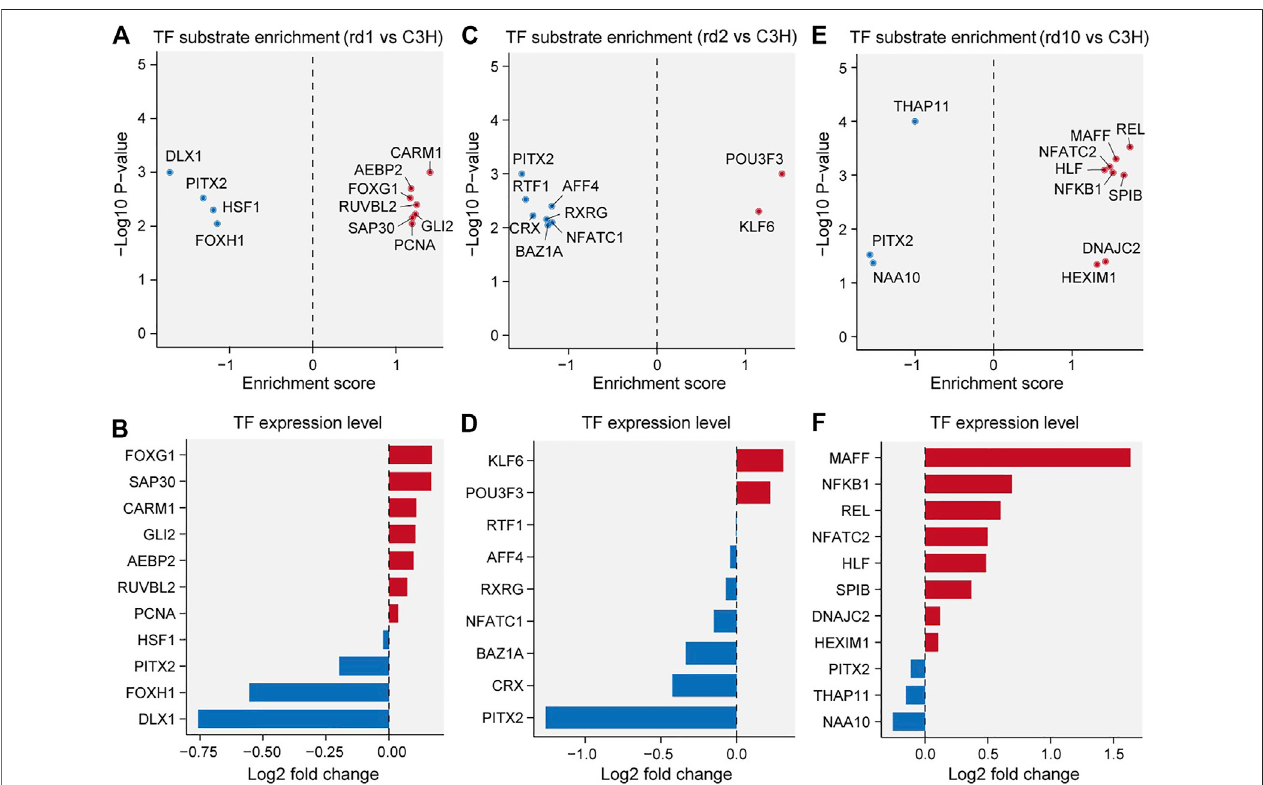
FIGURE 4 | Transcriptional factor (TF) substrate enrichment analysis in the three RD models versus C3H mice . (A, C, E) TF substrate enrichment score and signi fi cancein Pde6b rd1 (B) , Prph rd2 (D) ,and Pde6b rd10 (F) mice;PITX2werealldown-regulatedinRDmicecomparedwiththeC3Hmice. (B,D,F) Log2foldchangesof theindicatedTFexpressionlevelsin Pde6b rd1 (B) , Prph rd2 (D) ,and Pde6b rd10 (F) mice.FOXG1,KLF6,andMAFFwereup-regulatedinRDmice;whileDLX1andNAA10 were down-regulated in RD